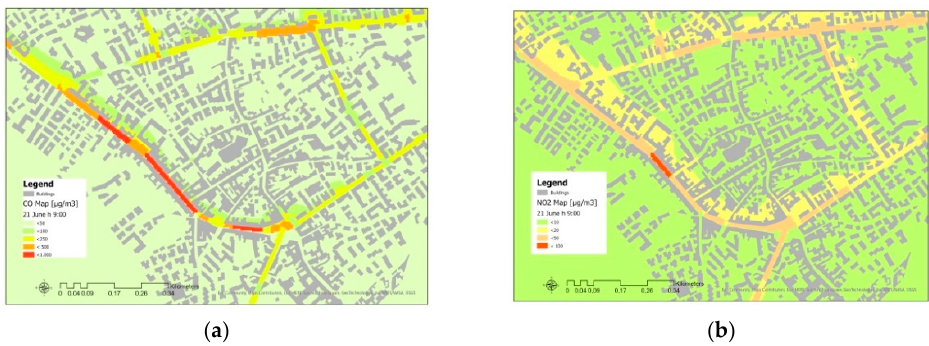
Figure A4. Maps of the estimated concentrations on 21 June at 9 a.m.: ( a ) CO concentrations; ( b ) NO 2 concentrations.